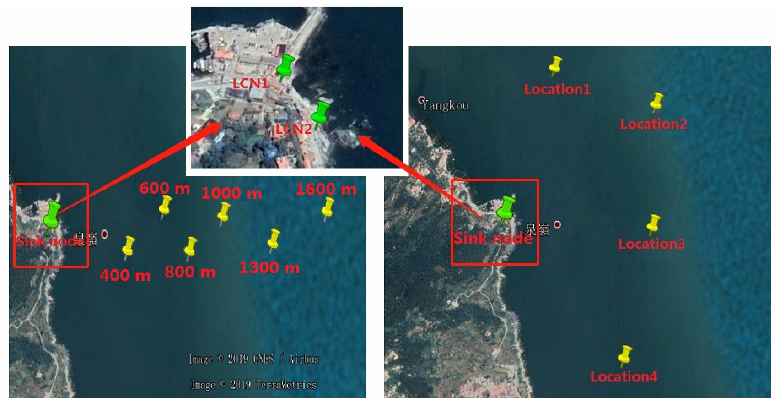
Figure 11. Locations of buoys and sink node in the ocean scenarios.